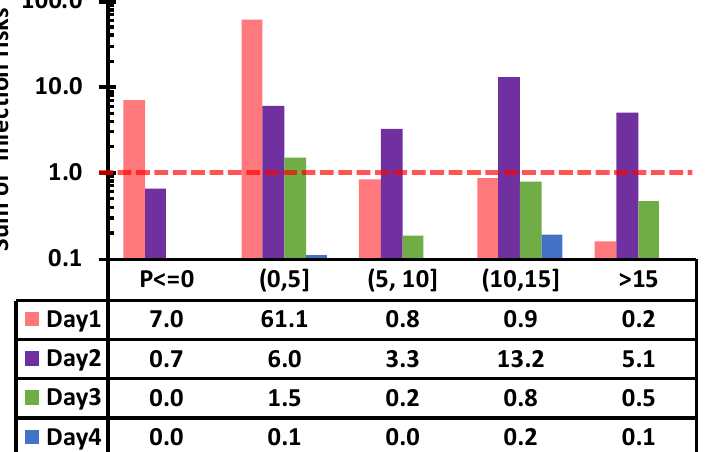
Figure 11. Number of infected people for different pressure (P) ranges (based on the pressure values under PDCs) on Days 1–4; Infection risks corresponding to the consumption event with F(x) = 1 (Figure 8) are illustrated. The event starts at 18:30 on Day 1 for a duration of 1 h. Daily patterns in the hydraulic model.